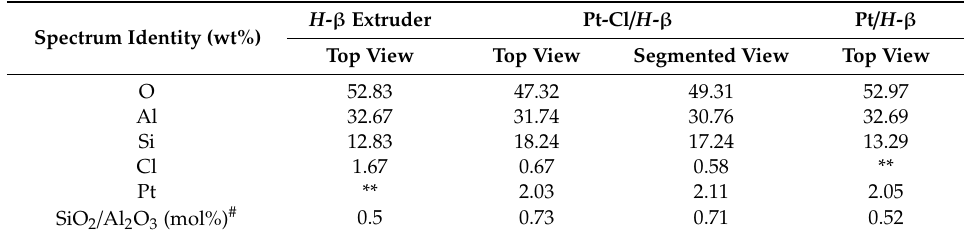
Table 3. The composition of elemental metals presents over the section of catalyst surface for segmented Extruder and Pt-Cl / H - β -zeolite by energy-dispersive spectroscopy (EDS) spectra collected following the SEM